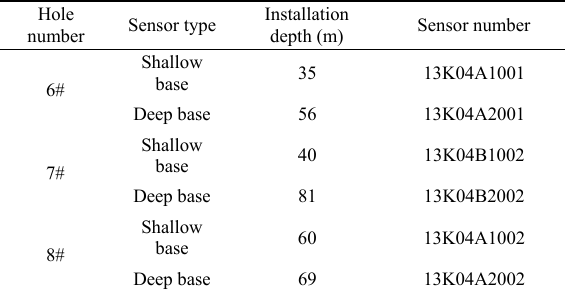
Fig. 5 Sensor installation plan. Table 1 Placement information of displacement sensors.